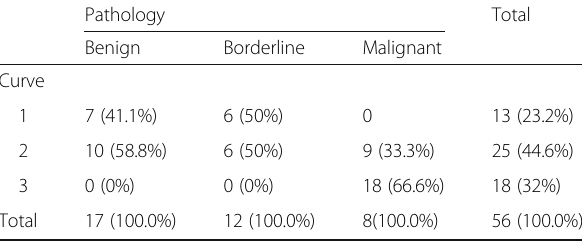
Table 6 Relation of the type of curve to the final pathology